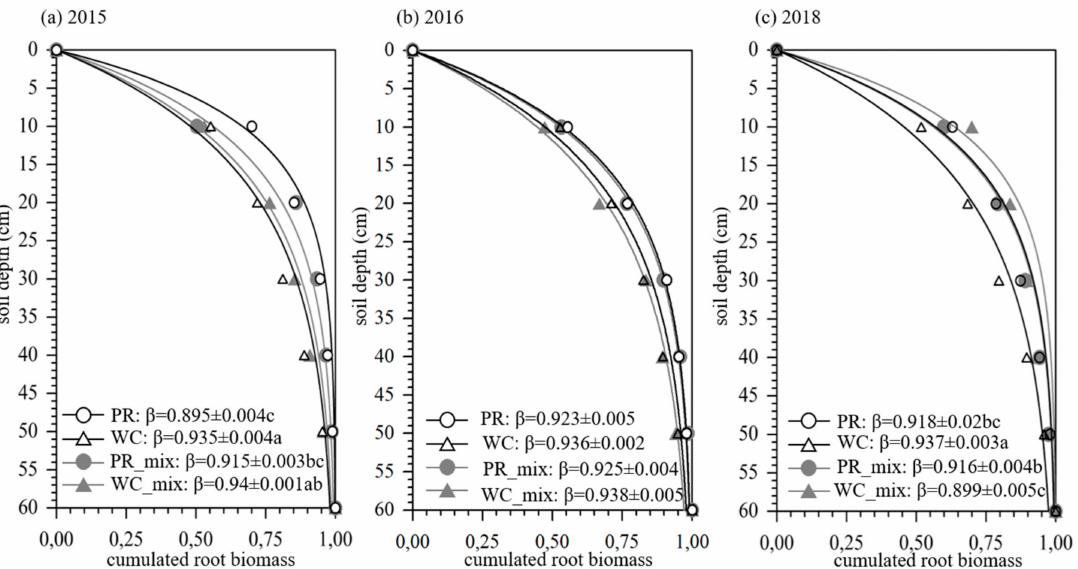
Figure 3. Vertical root distribution in ( a ) 2015, ( b ) 2016, and ( c ) 2018 of monocultures of unfertilized perennial ryegrass (PR), white clover (WC), and mixed stands of perennial ryegrass (PR_mix) and white clover (WC_mix). Average values of all WC genotypes are presented. Shown are fits of vertical root distribution ( β -values), according to [27]. R 2 was 1.00 in all